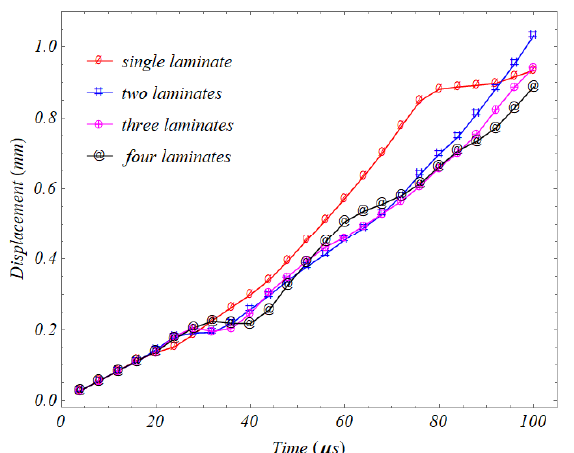
Fig. 29. Displacement against time for various number of cellphone casing laminates at 2500mm drop distance.